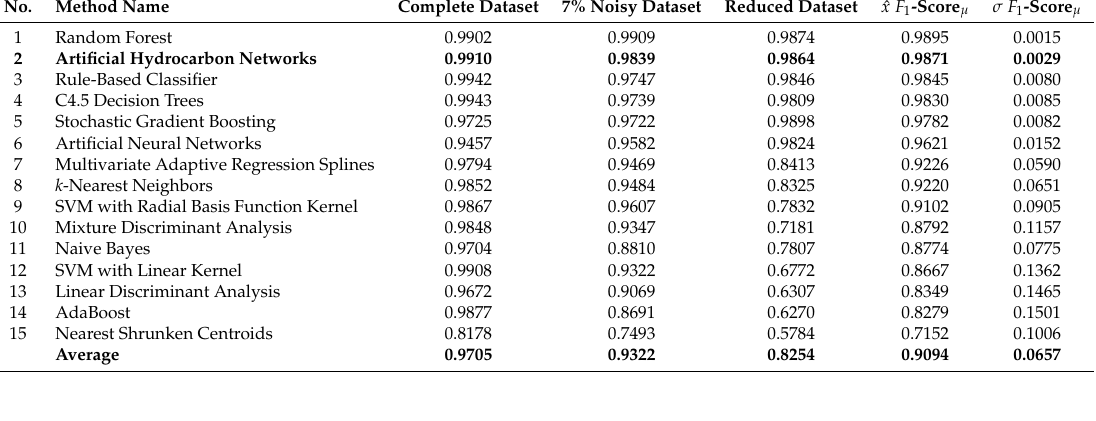
Table 19. Overall performance of supervised classifiers during the experiments with respect to the ˆ x F 1 -score µ metric.